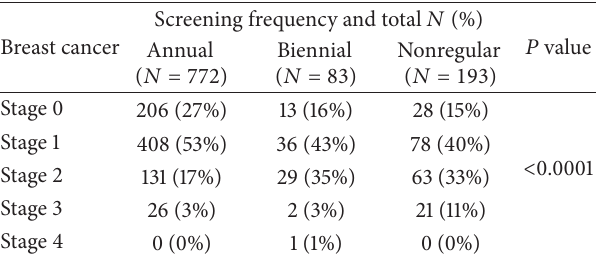
Table 3: Breast cancer stage at diagnosis and screening frequency. Breast